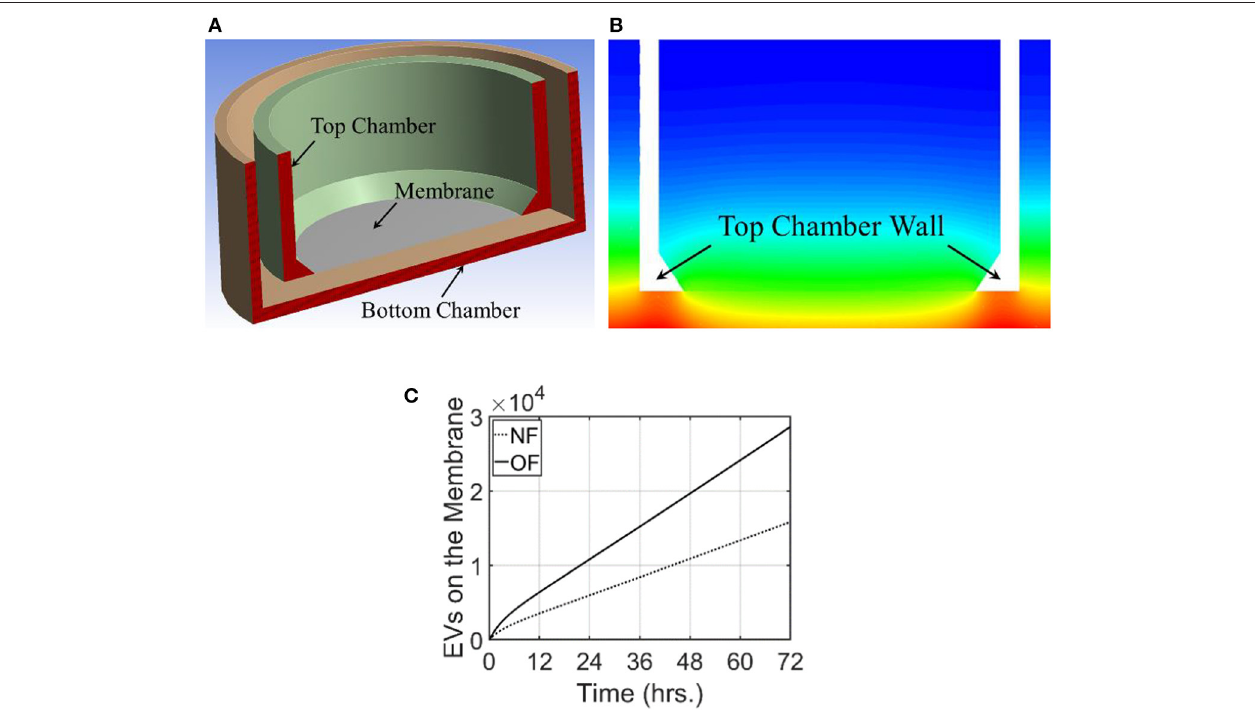
FIGURE 4 | Computational domain and the results from modeling of exosome transport in a transwell. For this modeling, exosome release rate for the cells placed at the bottom surface is taken as 515.3 and 986.3/h./10 5 cells for NF and OF, respectively. (A) A cross-sectional view of the 3-dimensional computational domain used for the simulation. (B) Exosome gradient on a plane through the middle of the transwell for NF after 72h. (C) A comparison of the number of exosomes at the membrane for NF and OF groups as a function of